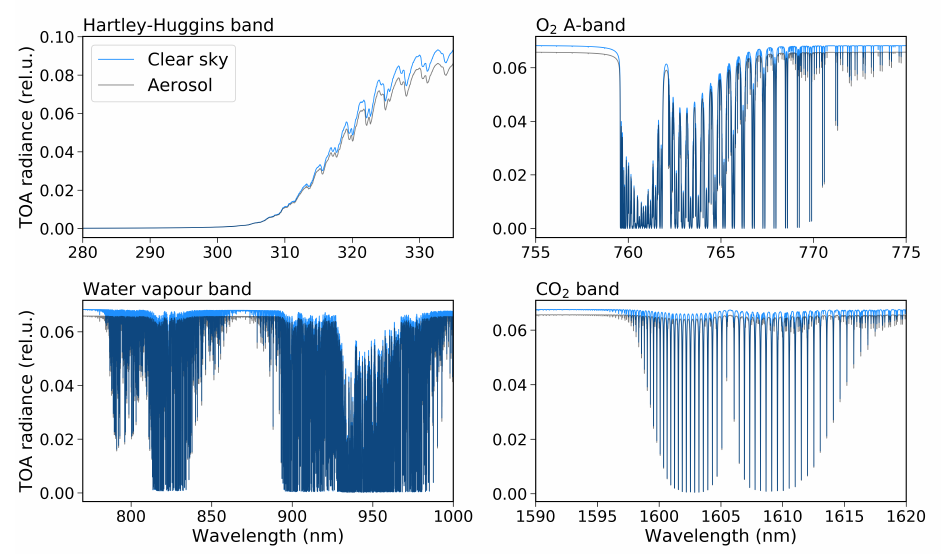
Figure 3. TOA radiances computed by using the MS RTM for the absorption bands: Hartley–Huggins, O 2 A-, water vapour and CO 2 bands. Blue lines correspond to the case without aerosol, while the black lines correspond to the specific case of desert